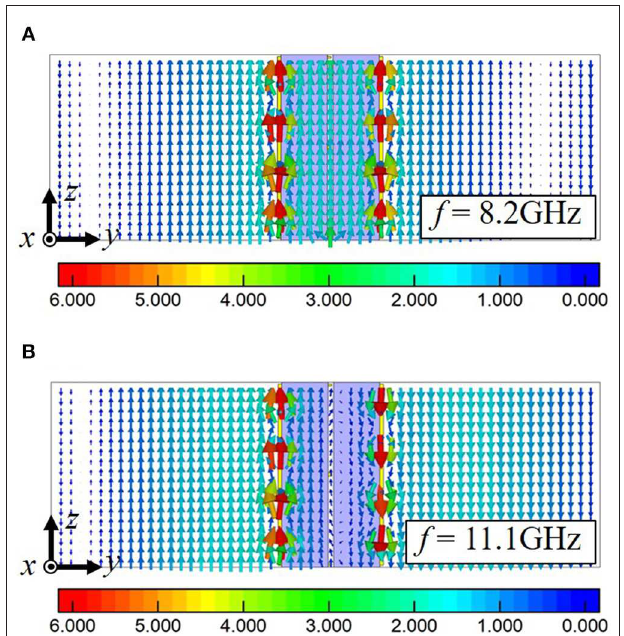
FIGURE 4 | The electric field distribution of (A) the symmetric mode at the perfect transparency frequency 8.2 GHz and (B) the anti-symmetric mode at the perfect transparency frequency 11.1 GHz.